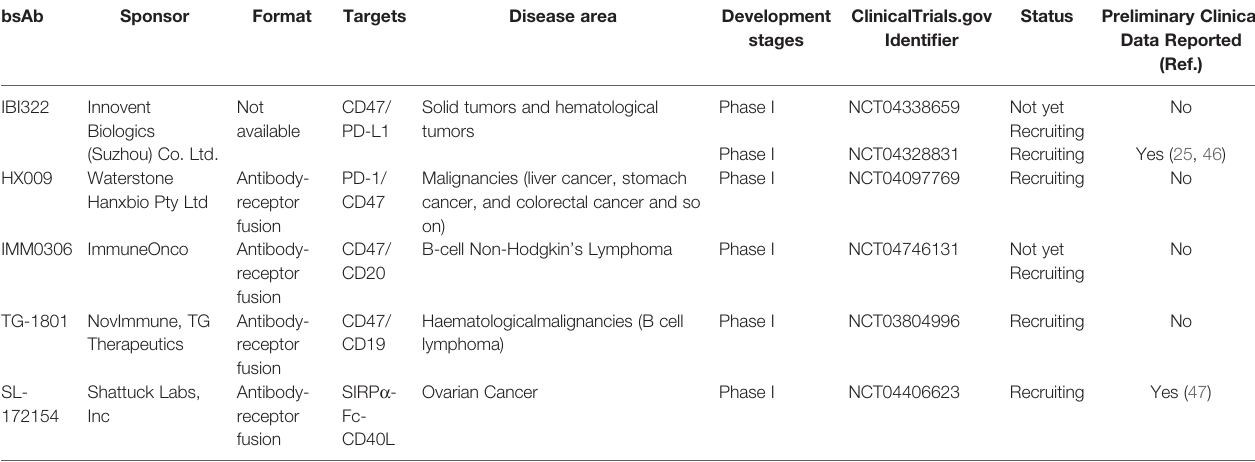
TABLE 1 | CD47-targeted bsAbs in clinical trials as of March 2021